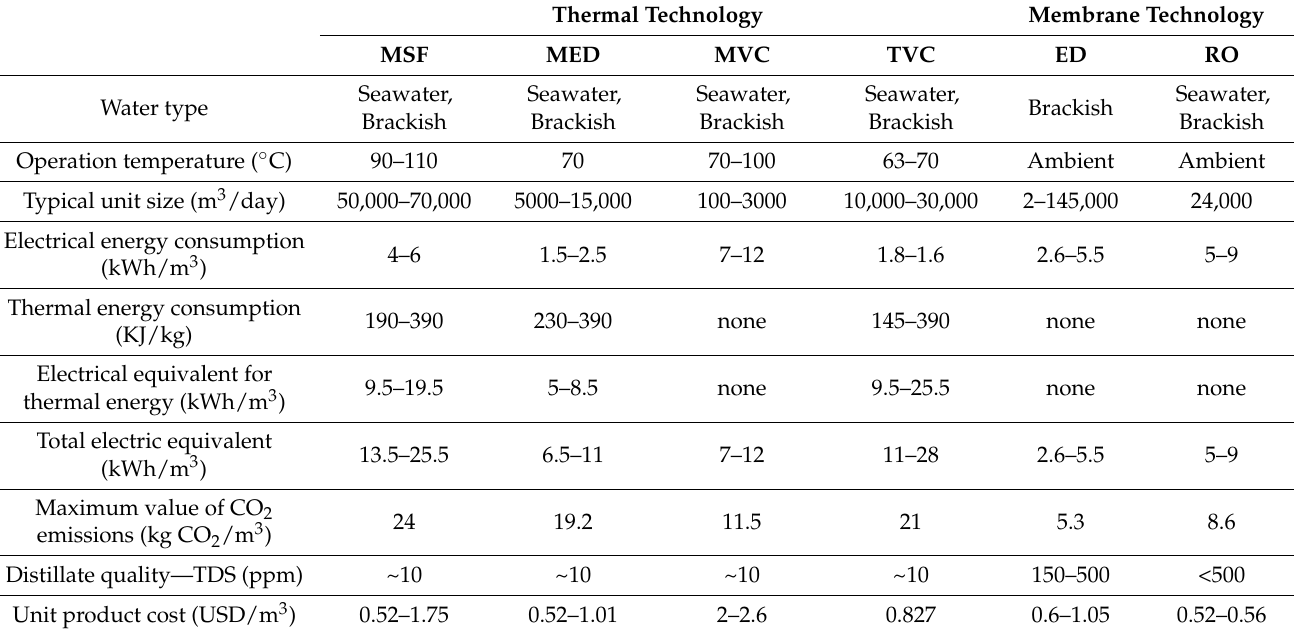
Table 3. Comparison of desalination techniques